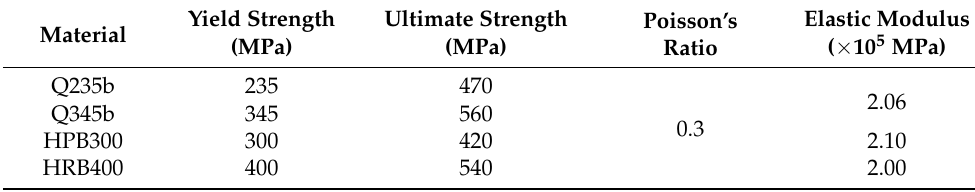
Table 1. Steel properties.